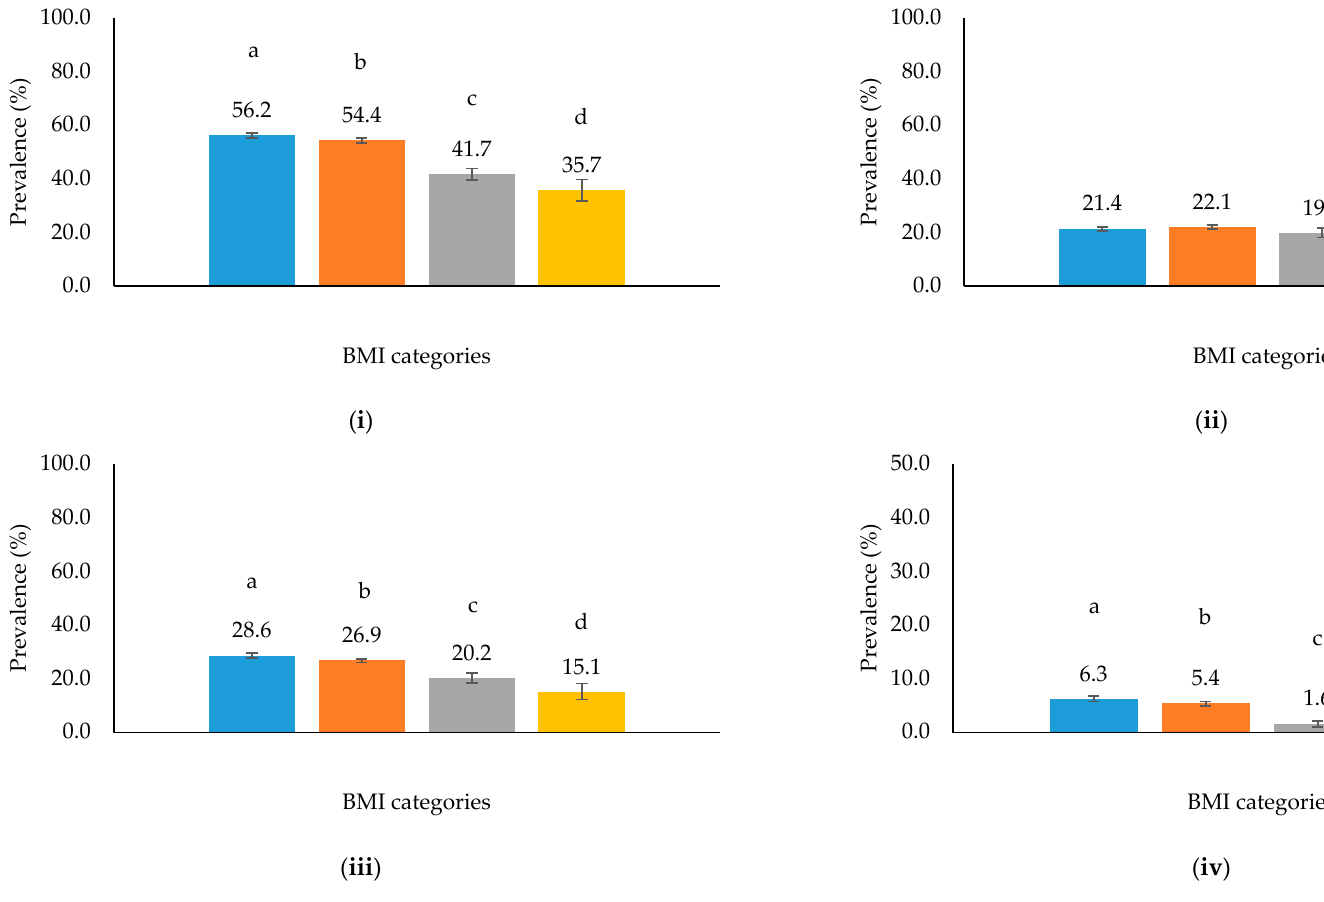
Figure 2. Prevalence of anemia by BMI categories (underweight: , normal: , overweight: , obese: ) among MaPPS Trial participants ( n = 25,447) at enrol- ment: ( i ) all types of anemia, ( ii ) mild anemia, ( iii ) moderate anemia, ( iv ) severe anemia. Bars with dissimilar letters are different ( p < 0.05).